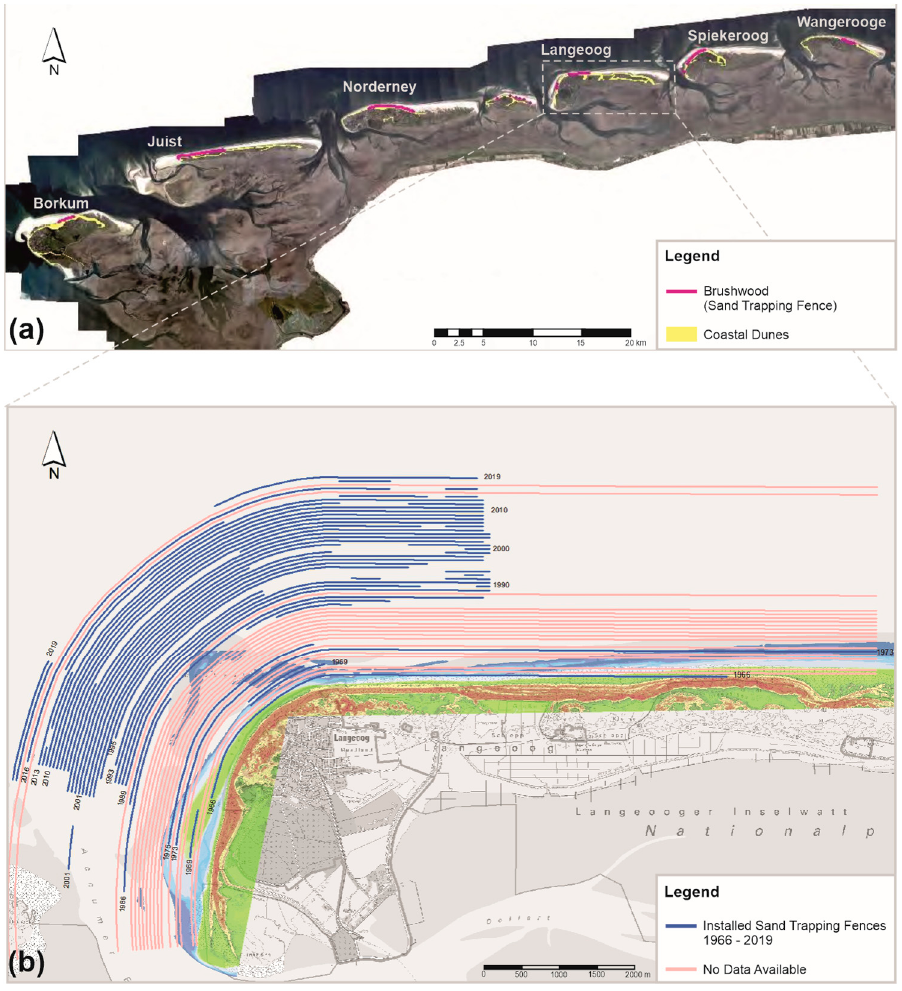
Figure 10. ( a ) Schematic overview of locations with installed sand trapping fences on East Frisian Islands, and ( b ) installations from 1966 to 2019 at Langeoog Island (UTM ETRS89 with German Geoid height GCG 2016).